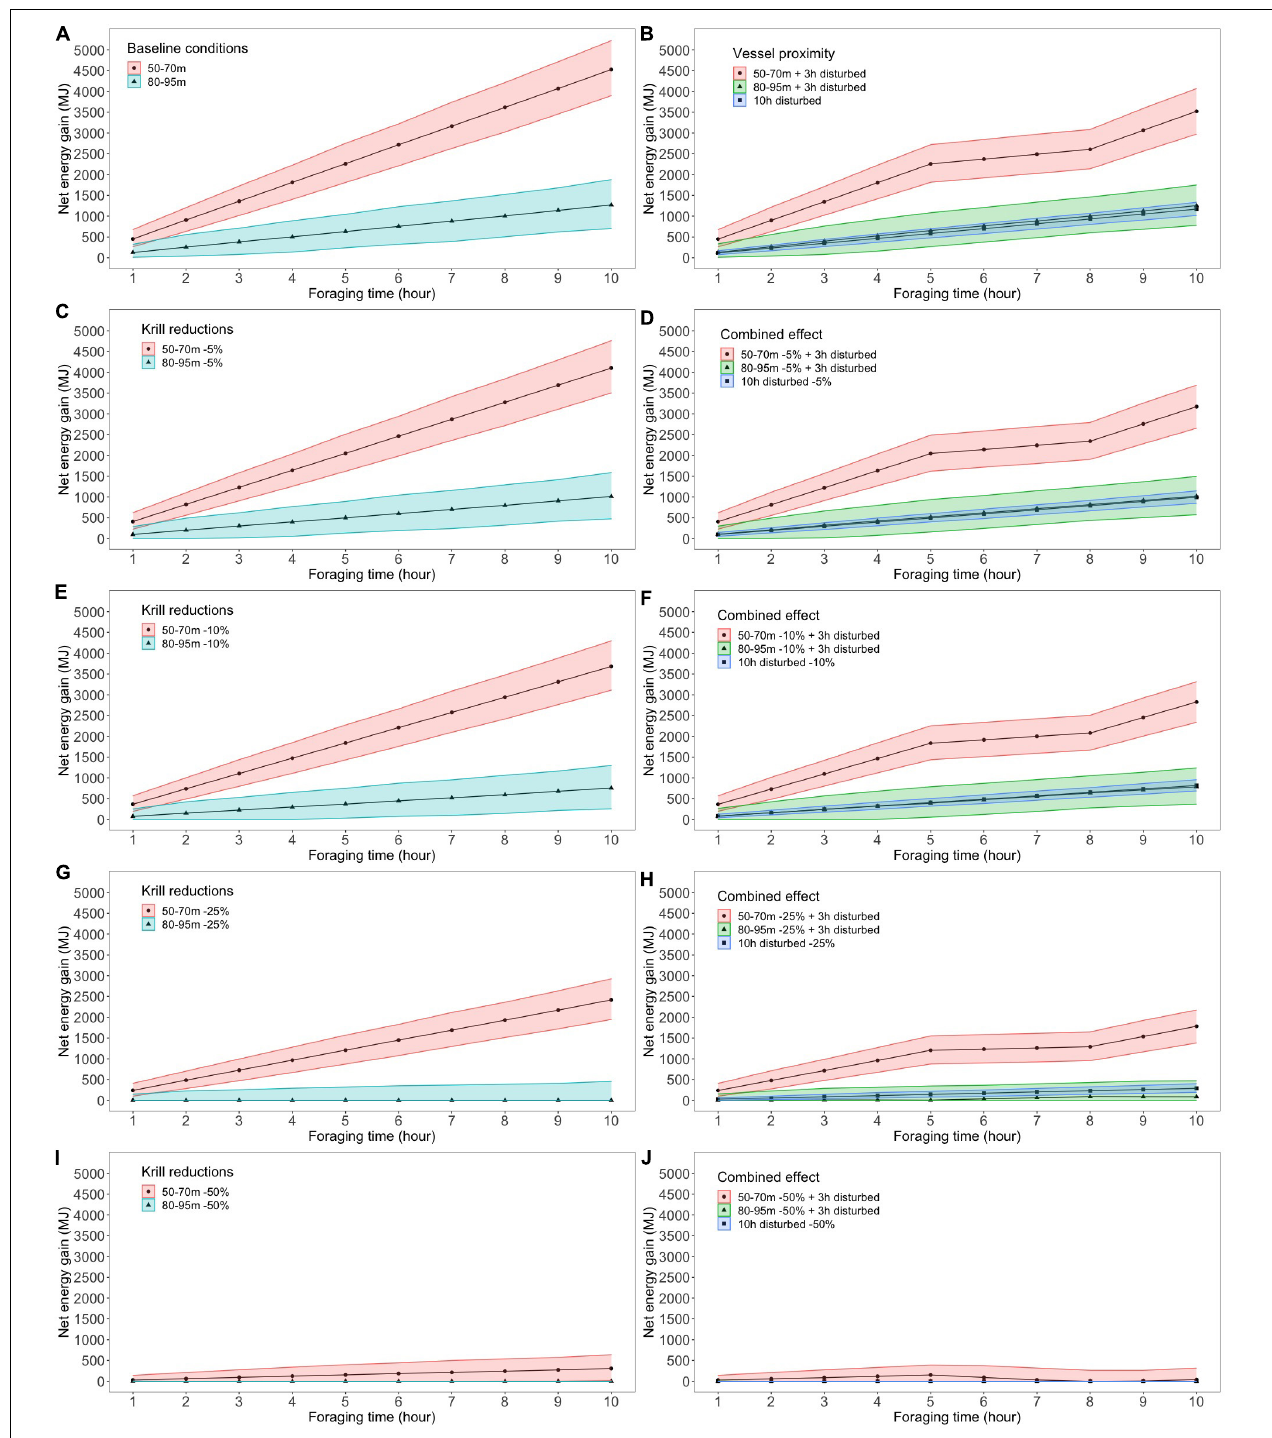
FIGURE 4 | Net energy gain (mean and 5–95% CI) accumulated over a 10 h foraging period when feeding on M. norvegica in the St. Lawrence Estuary, (A) under baseline conditions measured in situ , (B) when exposed to vessel proximity within 400 m for 3 h (from hour 5 to hour 8) and 10 h, (C,E,G,I) under krill density reductions of 5, 10, 25, or 50% relative to baseline, and (D,F,H,J) while foraging on reduced krill densities when exposed to vessel proximity. Patterns for Thysanoessa spp. and the NWG are presented in the Supplementary Material .